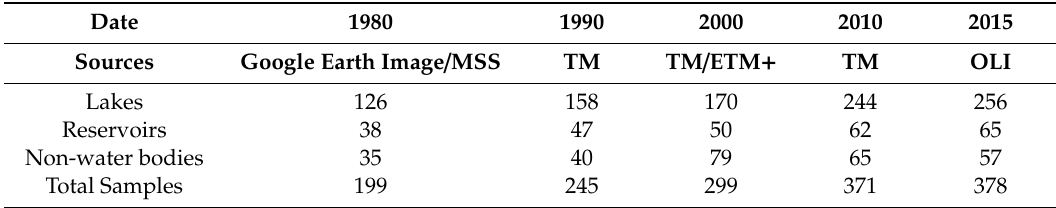
Table 1. Collected validation samples for the five dates.